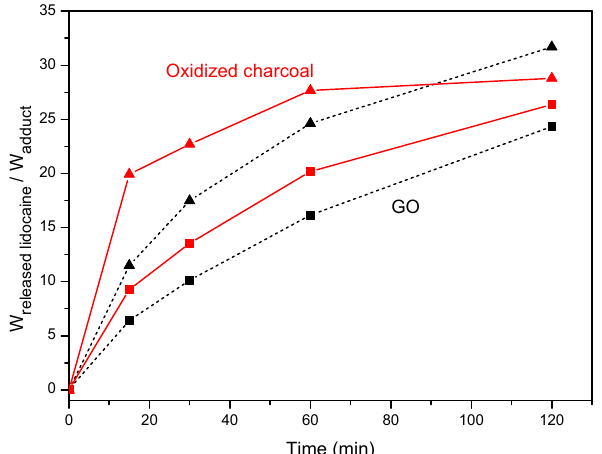
Figure 5. Lidocaine release from its adducts with oxidized charcoal (red continuous curves) and with graphite oxide (GO) (black dashed curves), in neutral (squares) and acidic (pH = 1.3; triangles) solutions.